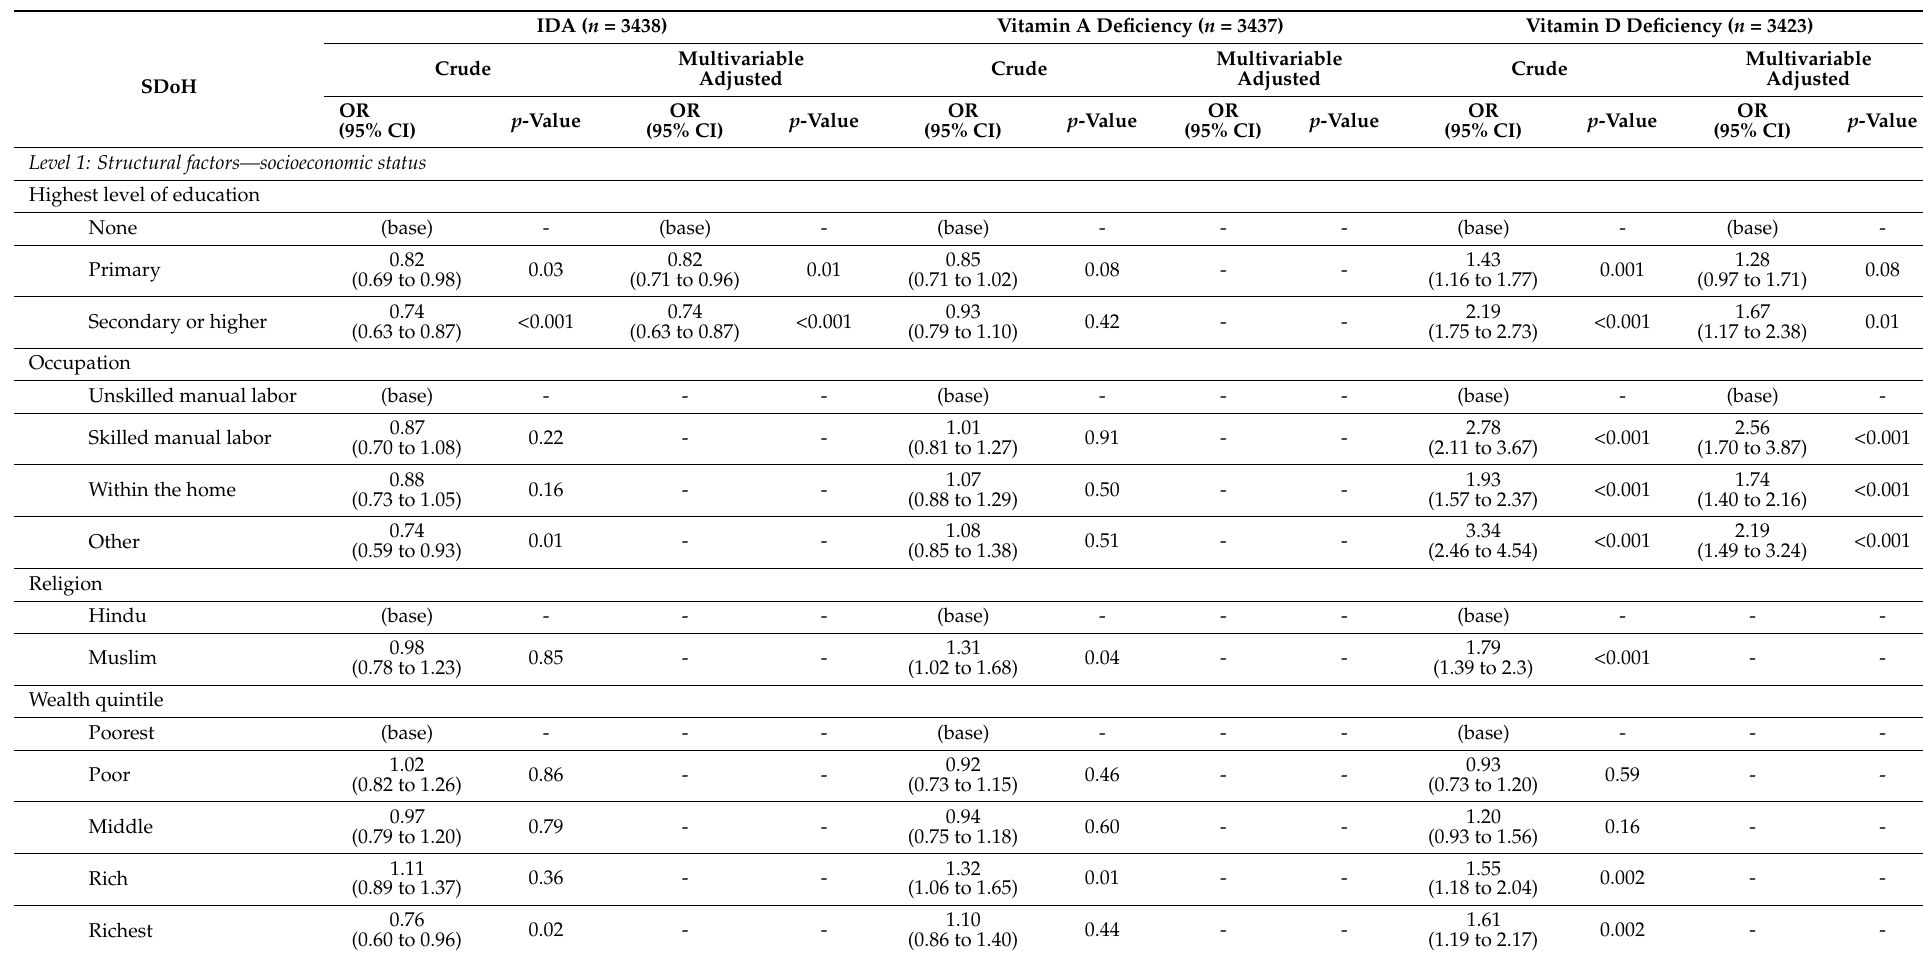
Table 4. Comparison of SDoH with IDA, vitamin A deficiency (VAD), and vitamin D deficiency (VDD) among adolescent girls enrolled in the MaPPS Trial micronutrient status subgroup.